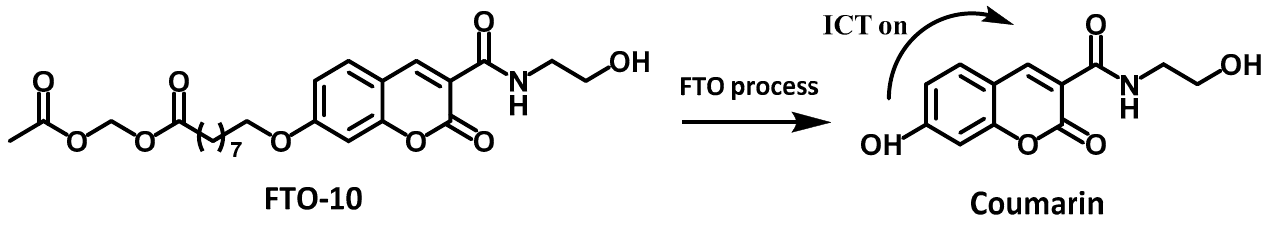
Figure 19. Structure and sensing mechanism of the probe FTO-10 .